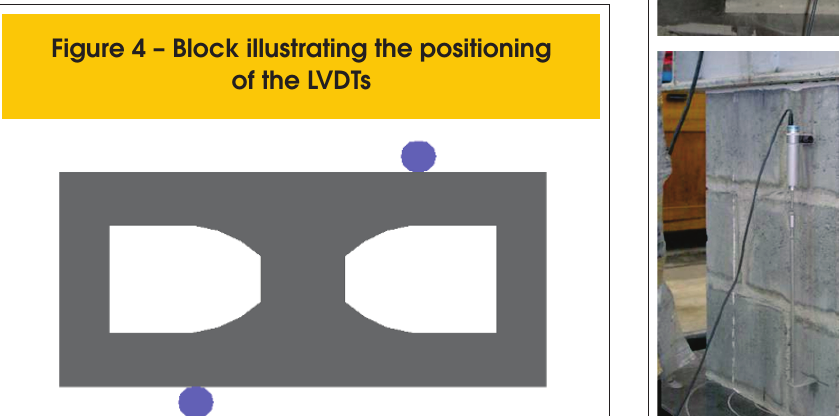
Figure 4 – Block illustrating the positioning of the LVDTs